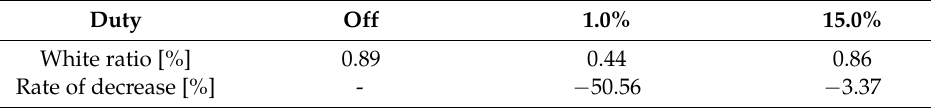
Figure 32. Snow accumulation test (arc model) [Result_2]. Table 3. Snow accumulation test (arc model) [Result_1].